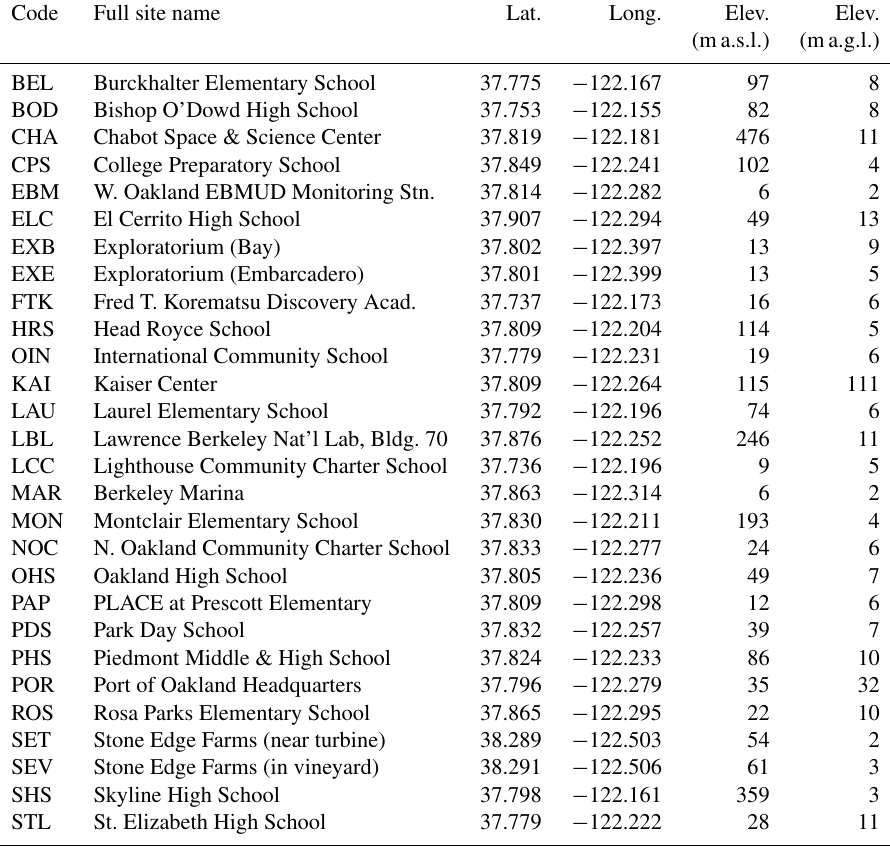
Table 1. List of site names, abbreviated codes, geo-coordinates, and elevations.